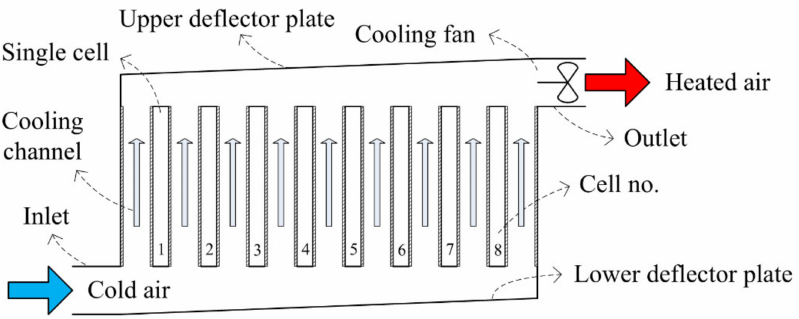
Figure 13. 2-D schematic of the parallel air-cooling arrangement assumed for the 8S module